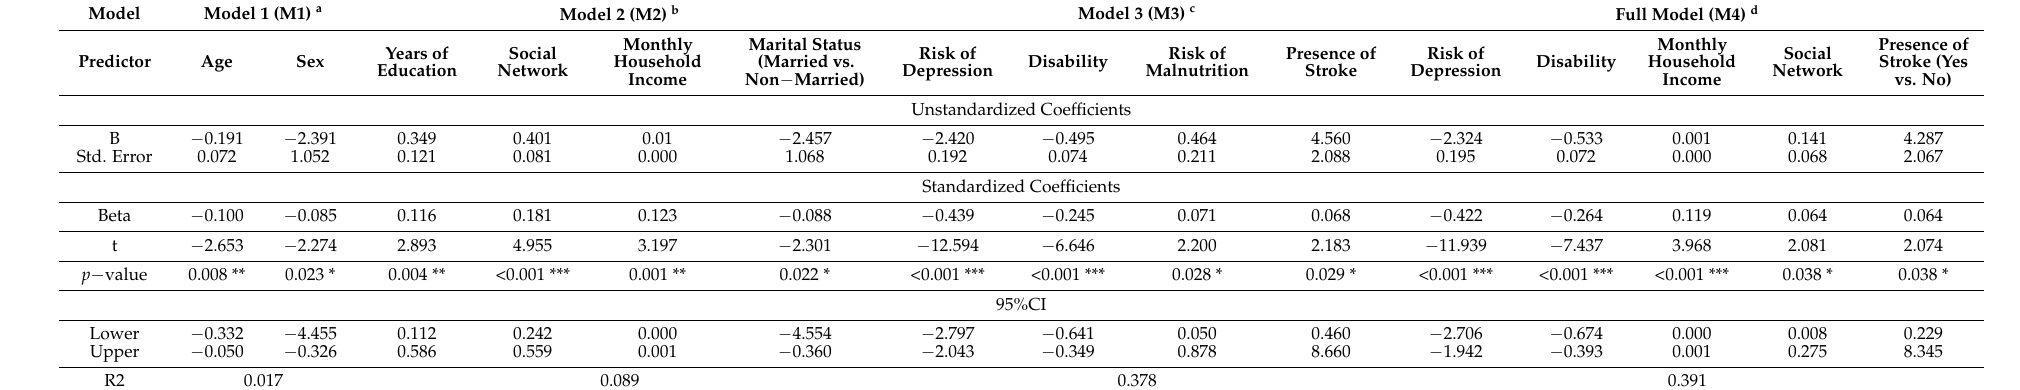
Table 3. Stepwise linear regression analysis of the predictors of quality of life among community-dwelling older